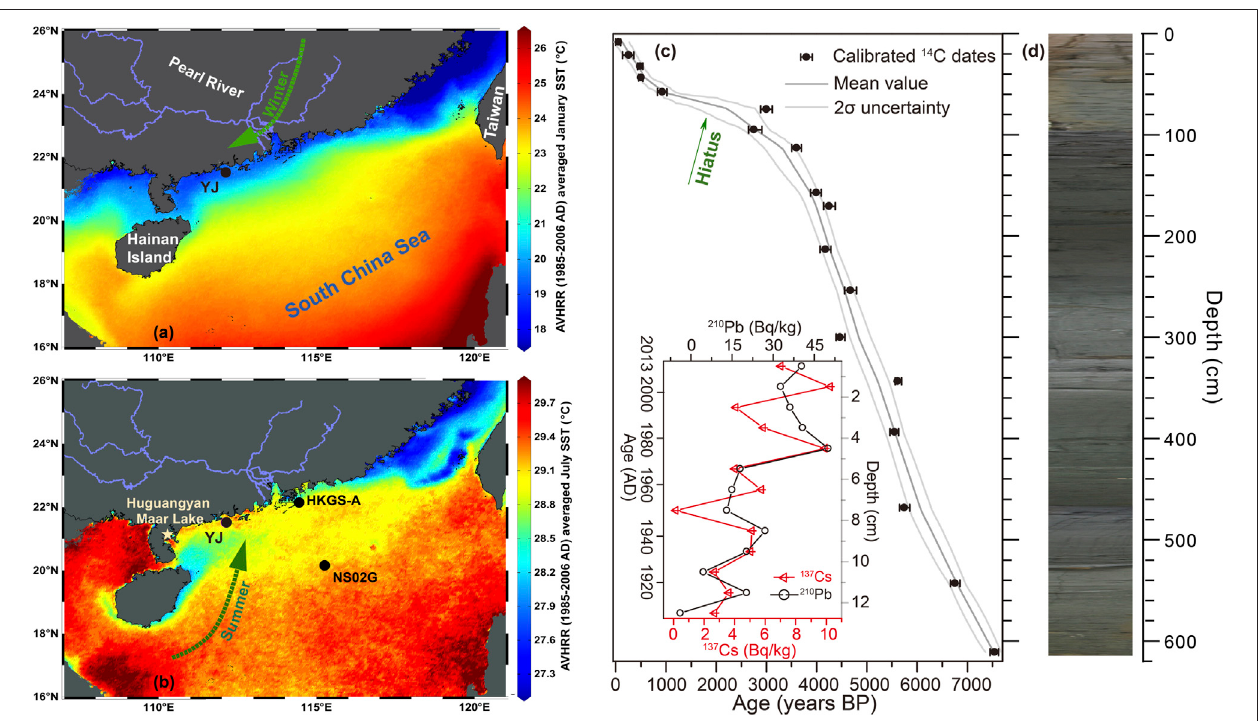
FIGURE1| RegionalsettingandthesiteofcoreYJ,existingpaleorecords inthenorthernSouthChinaSea(blackdots)andatHuguangMaarLake(orangestar)as mentionedinthemaintext,areplottedagainstlong-term(1985 – 2006AD)averagedJanuary (A) andJuly (B) seasurfacetemperature(SST,colorscale)fromtheAVHRR dataset (Casey, 2013). Chronology (C) and lithology (D) of core YJ are cited from Huang et al. (2018) and Zhang et al. (2019). Note that the core-top (C) is calculated based on 210 Pb/ 137 Cs dates, to be 2013 AD when our core YJ was retrieved.